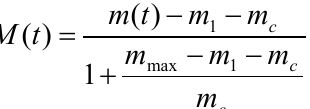
- mass of water; m - mass of water + c 1